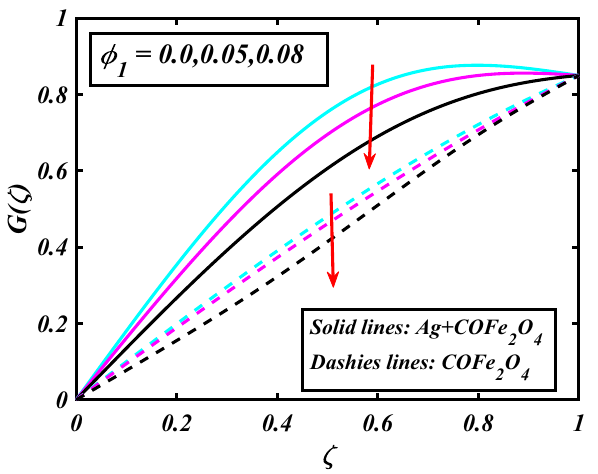
Figure 6. Demonstration of φ 1 through G (ζ) .